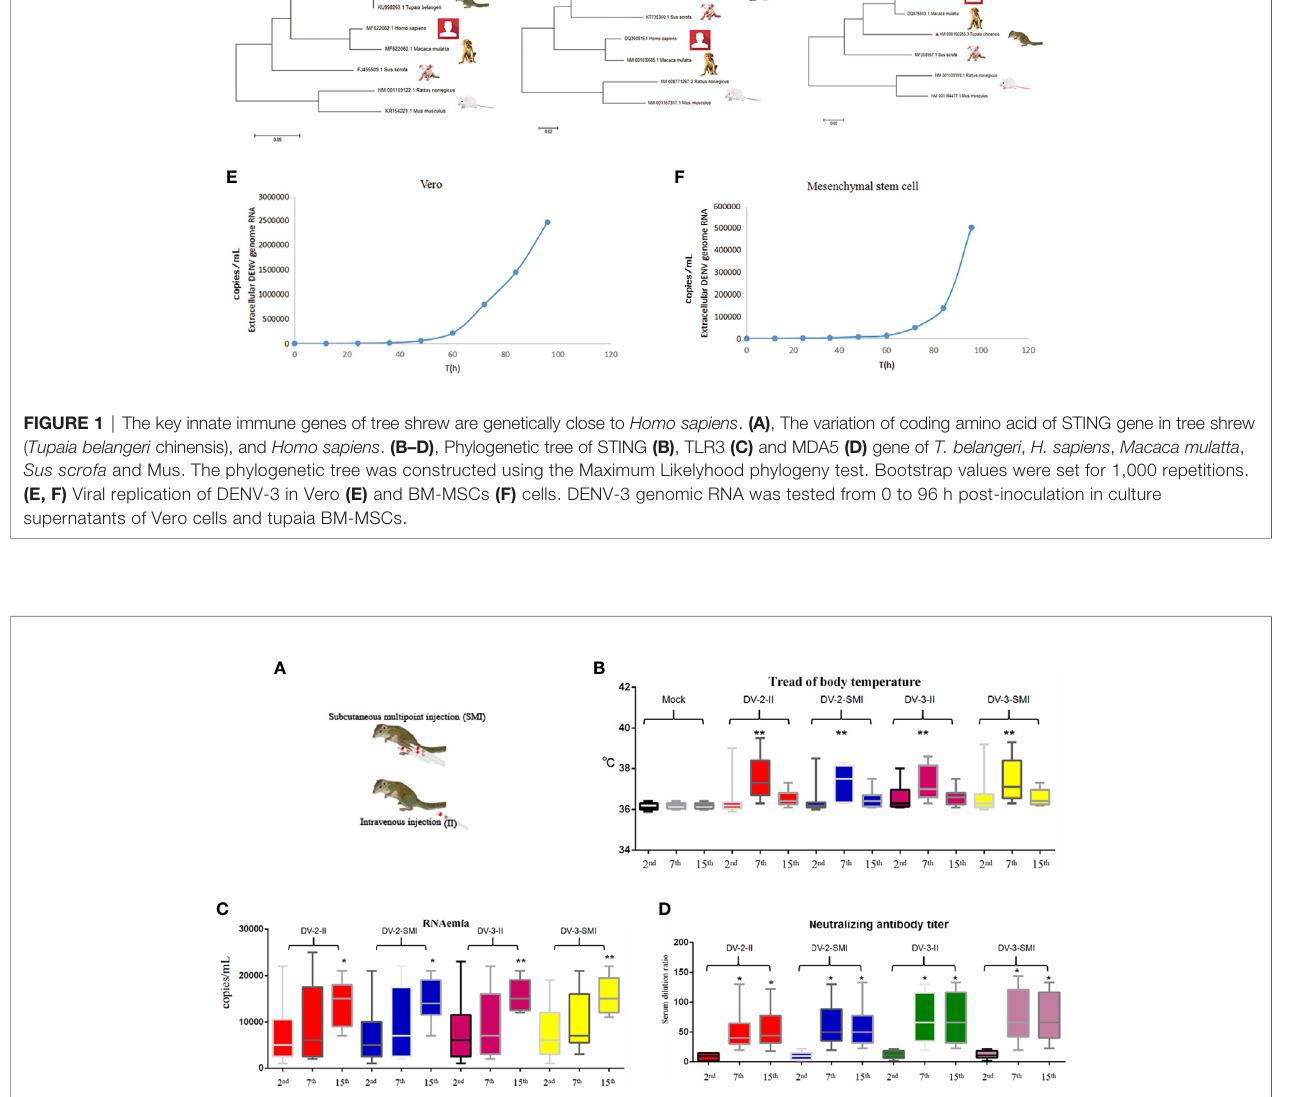
FIGURE 2 | Fever, viremia and neutralizing antibody level of DENV-2 and DENV-3-inoculated tree shrew (n = 9 per group). (A) Schematic diagram of subcutaneous multipoint injection (SMI) and intravenous injection (II) in tree shrew. (B) The fever situations of the entire experimental process. The results from each group were compared using Student ’ s t test. **P <0.01. (C) The viral load in the serum. The viral RNA copies wERE tested at the day after blood collection on the 2nd, 7th and 15th days post injection. (D) The neutralizing titer in the serum after injection was observed on the 2nd, 7th and 15th days. The results from each group were compared using Student ’ s t test. *P <0.05, **P <0.01, ***P <0.001.